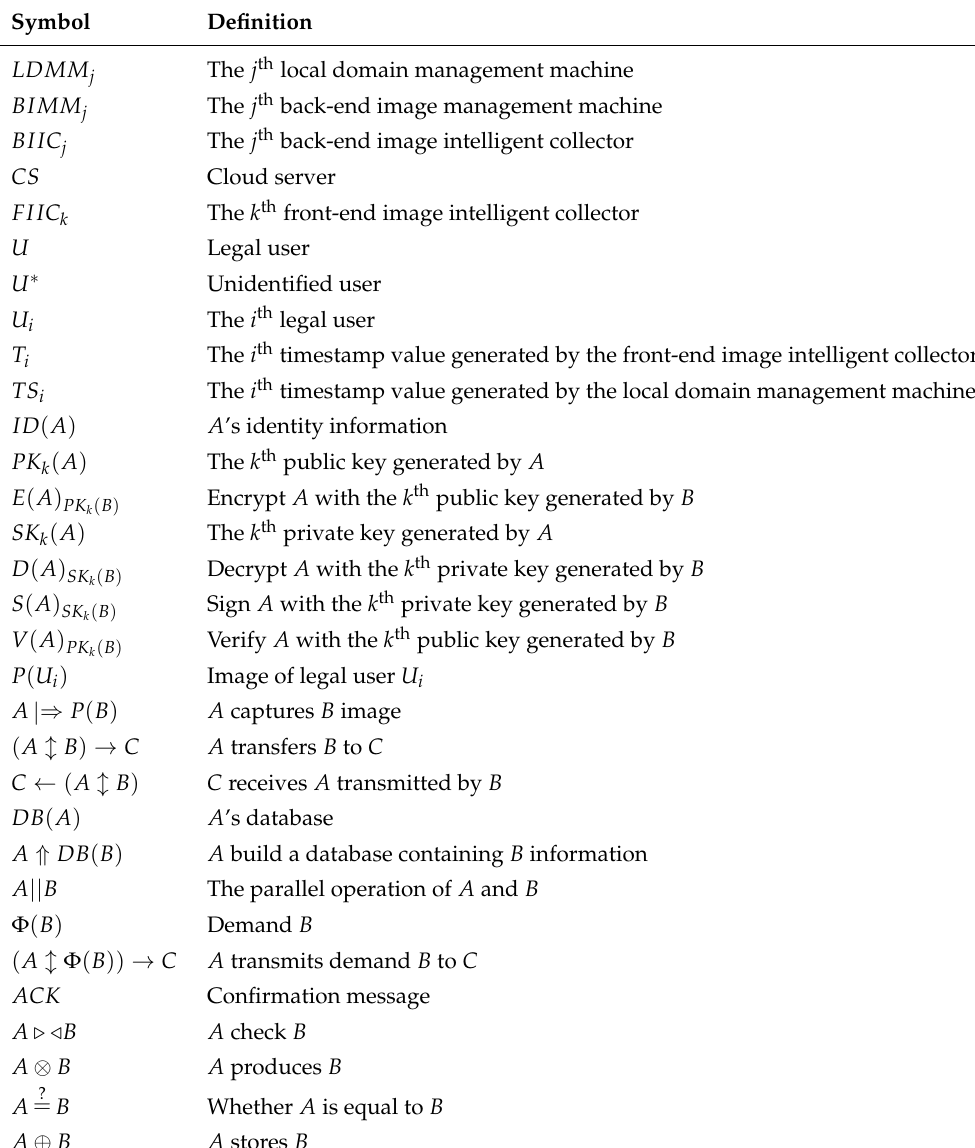
Table 1. Symbols and